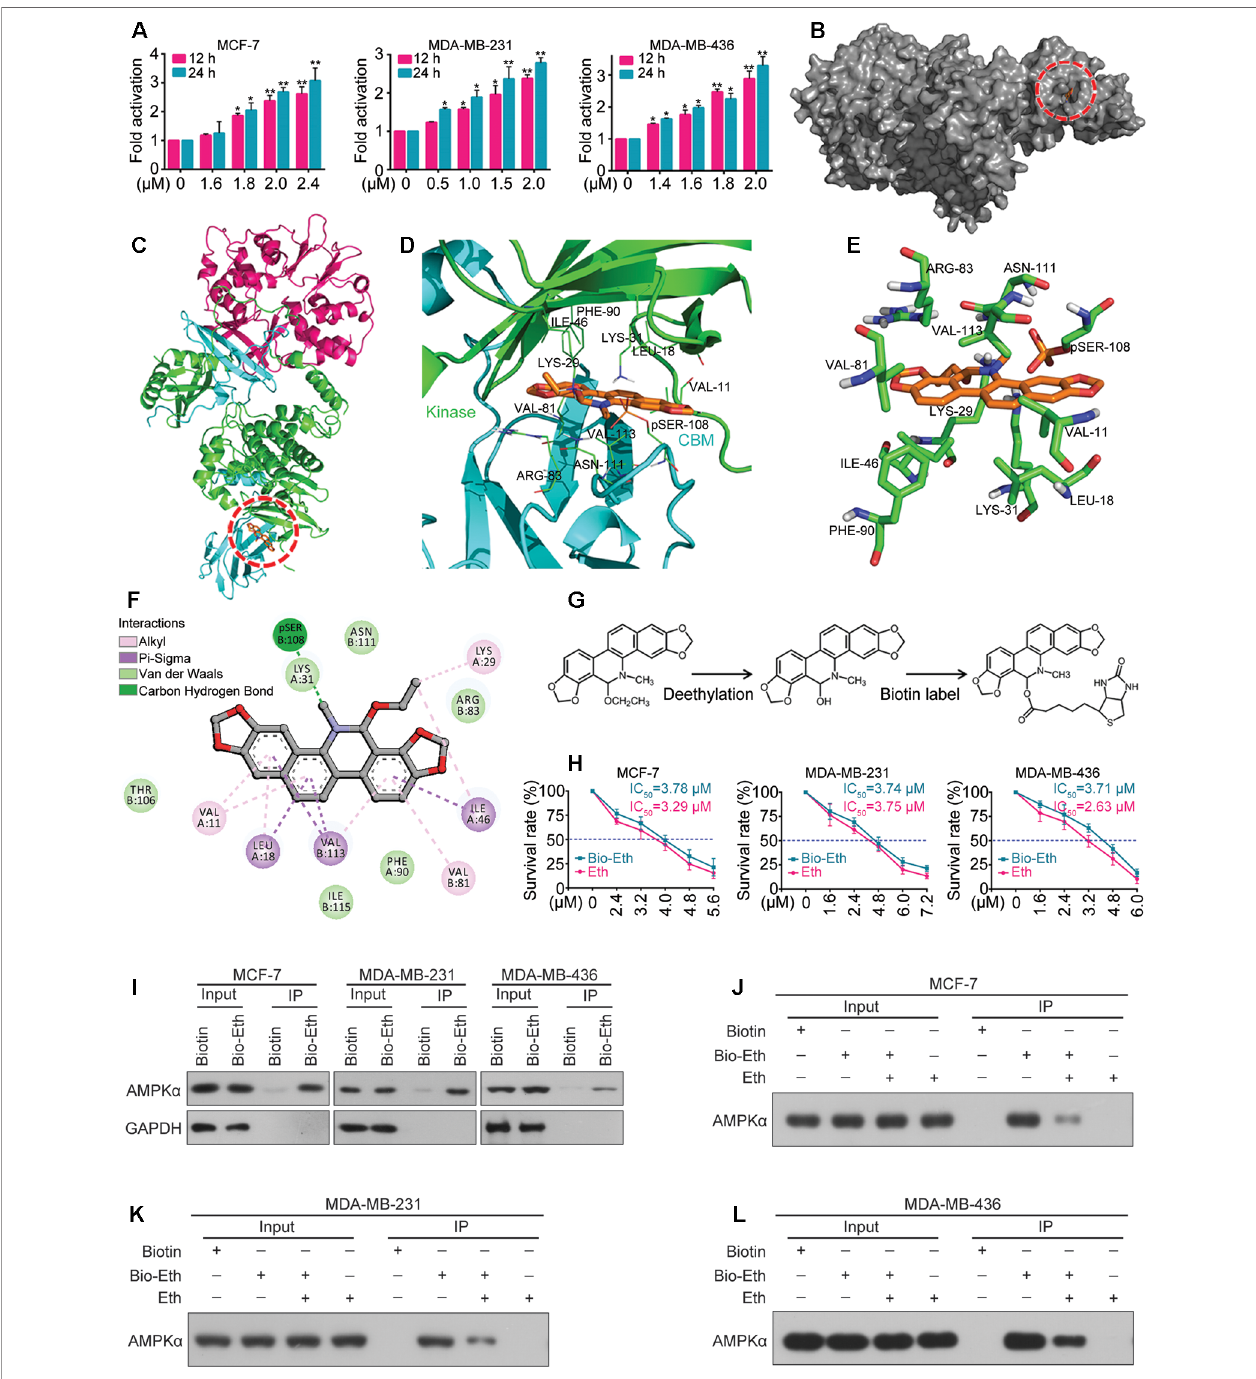
FIGURE 4 | Eth is a direct activator of AMPK. (A) : MCF-7, MDA-MB-231, or MDA-MB-436 cells were treated with increasing concentrations of Eth for 24 h, and AMPK activity assay was performed. (B) : The binding mode of Eth docked into AMPK. (C) : The binding mode of Eth docked into AMPK. a subunit is green, b subunit is cyan, g subunit is magenta and Eth is gold. (D) : Details of the binding site of Eth in the ADaM site of AMPK. The main residues involved in drug interactions are shown as labeled green sticks. a subunit is green, b subunit is cyan. The pSER-108 was shown in stick and colored by gold. (E) The interaction pattern of Eth with the residues. (F) : The 2D representation of the AMPK crystal structure in complex with Eth. (G) : Chemical structure of Eth intermediate and Biotin-labeled Eth. (H) : Viability of MCF-7, MDA-MB-231 or MDA-MB-436 cells exposed to Biotin-Eth as determined by MTT assay. (I) : MCF-7, MDA-MB-231, or MDA-MB-436 cells were treated with 4 m M Biotin or Bio-Eth for 12 h, lysed, and the cell lysates were subjected to immunoprecipitation using S. agarose and western blot using indicated antibodies. (J – L) : MCF-7, MDA-MB-231, or MDA-MB-436 cells were treated with Bio-Eth (4 m M) in the presence or absence of Eth (12 m M) for 3 h, lysed, and the cell lysates were subjected to immunoprecipitation and western blot. * P < 0.05, ** P <